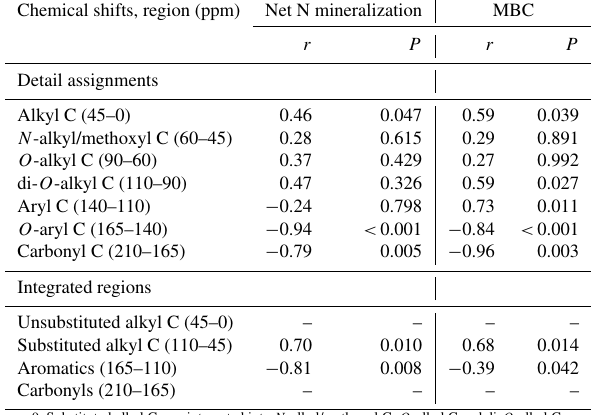
Table 8. Summary of the linear correlation for relationships be- tween net N mineralization, MBC and all the C functional groups of SOC determined by CPMAS 13